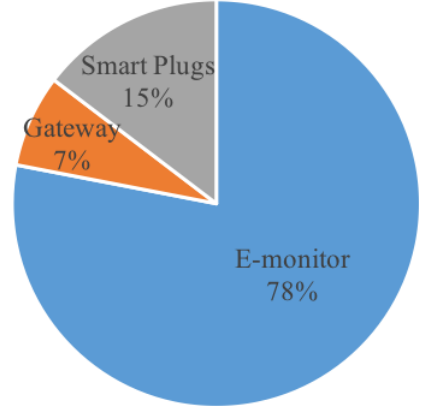
Figure 2. Different categories of e-monitors.